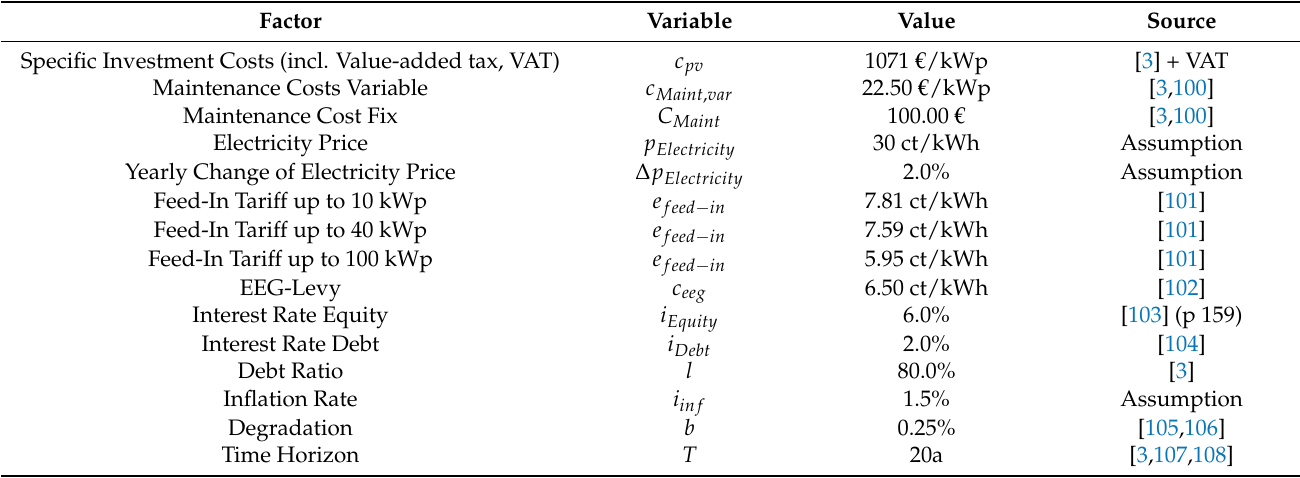
Table A4. Summary of economic